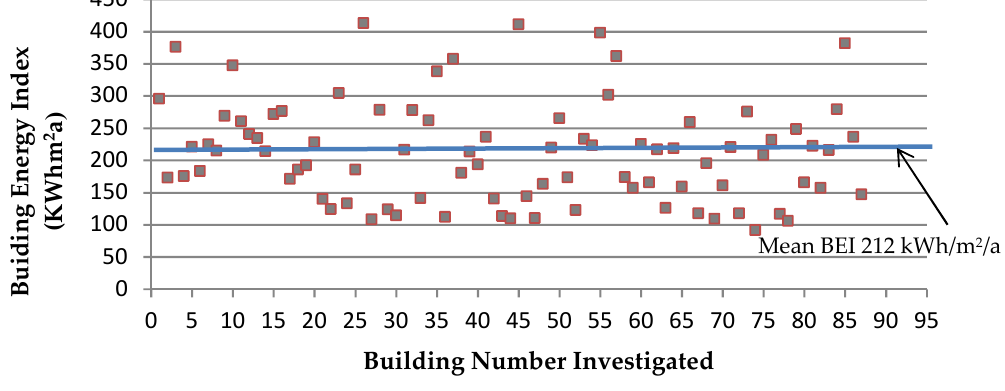
Figure 4. Building energy indices of 87 buildings.